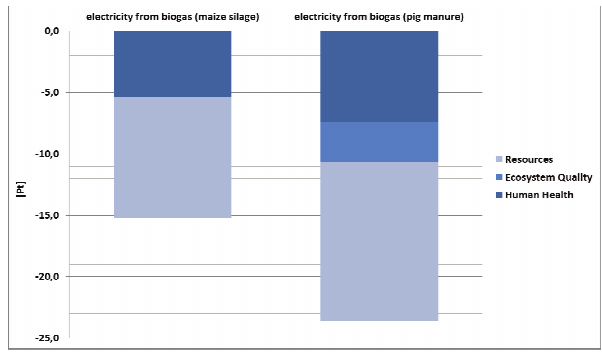
Fig. 6. Results of a comparative analysis of a 1 MWh of electricity produc- tion from biogas obtain from corn silage, distillery slop and sugar Fig. 4. Sankey graph for 1 MWh of electricity production from biogas obtain from corn silage, distillery slop and sugar beet pulp (material- energy balance fragment)